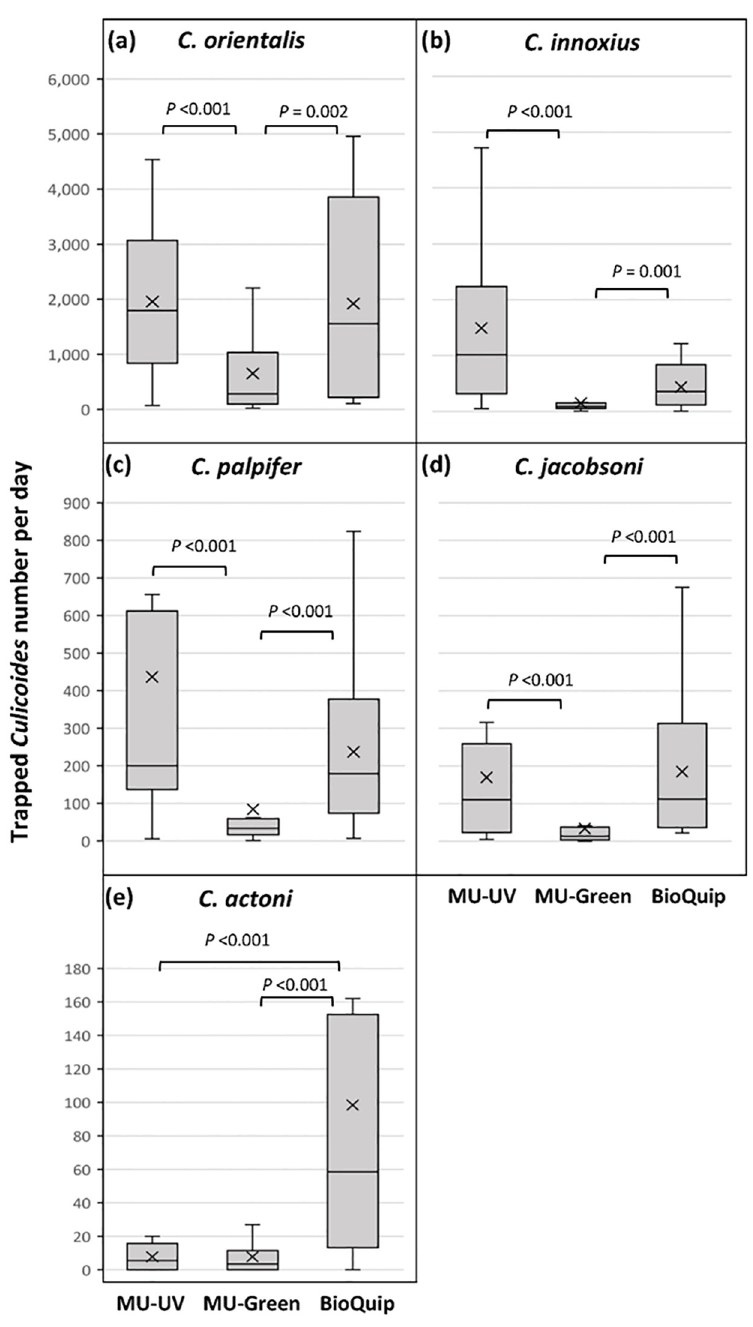
Fig 3. Box-and-whisker plots of the daily total number of the five most abundant Culicoides species collected with three different LED light traps over 12 nights between 26th July and 7th August 2020 in Sai Yok District, Kanchanaburi Province, Thailand. The total counts of the five most abundant species are shown. The cross marks in the middle of bars indicate the mean of the collection number per day.